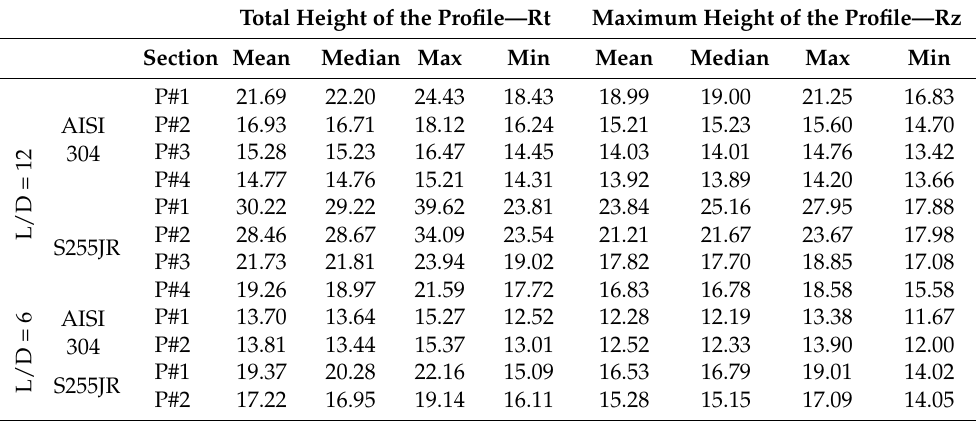
Table 6. Main statistics of the total height of the profile (Rt) and maximum height of the profile (Rz) parameters. Total Height of the Profile—Rt Maximum Height of the